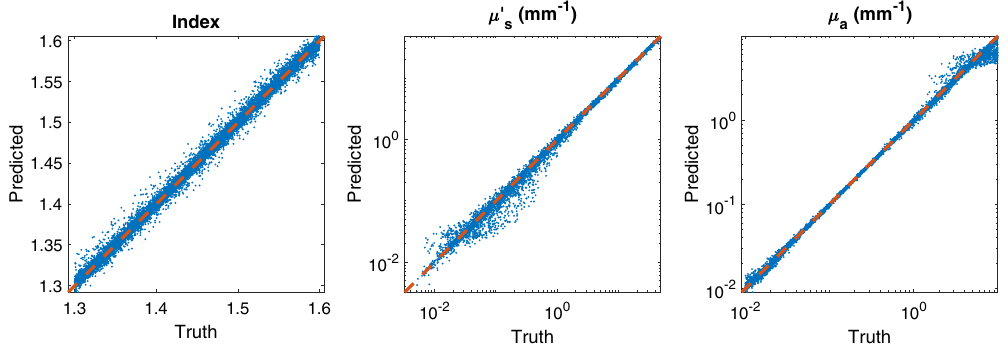
Figure 3. Prediction versus truth for a [21, 150, 150, 150, 3] fully connected neural network illustrating the robustness of this approach over the majority of the problem space. The dashed red line is the line y = x which would correspond to a perfect